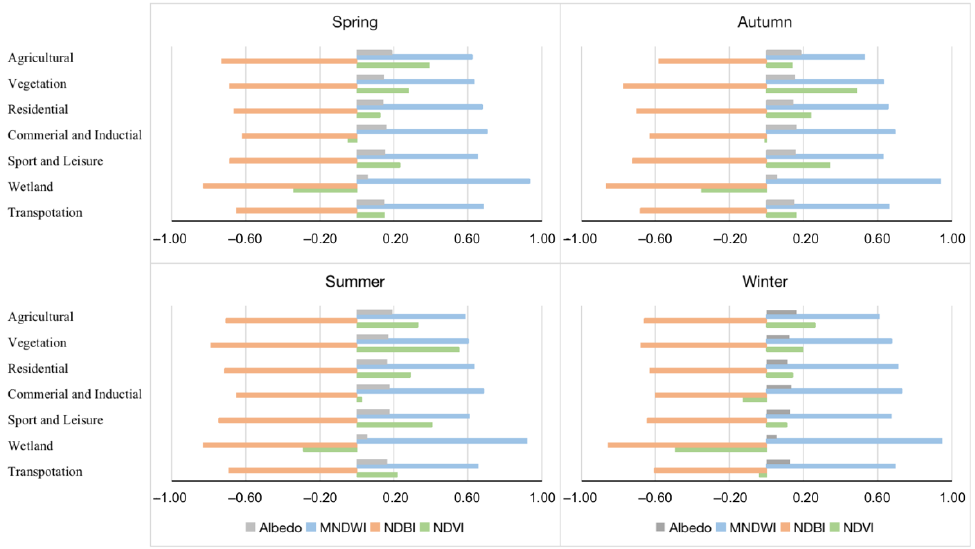
Figure 8. The season variation of the land cover factors by land cover type in daytime.